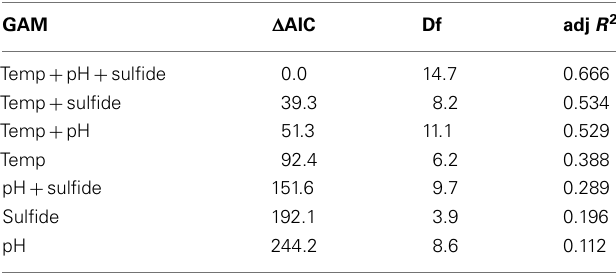
Table 2 | Statistics for GAMs whereby a binary dataset of the distribution of phototrophy in 439 springs inYNP served as the response